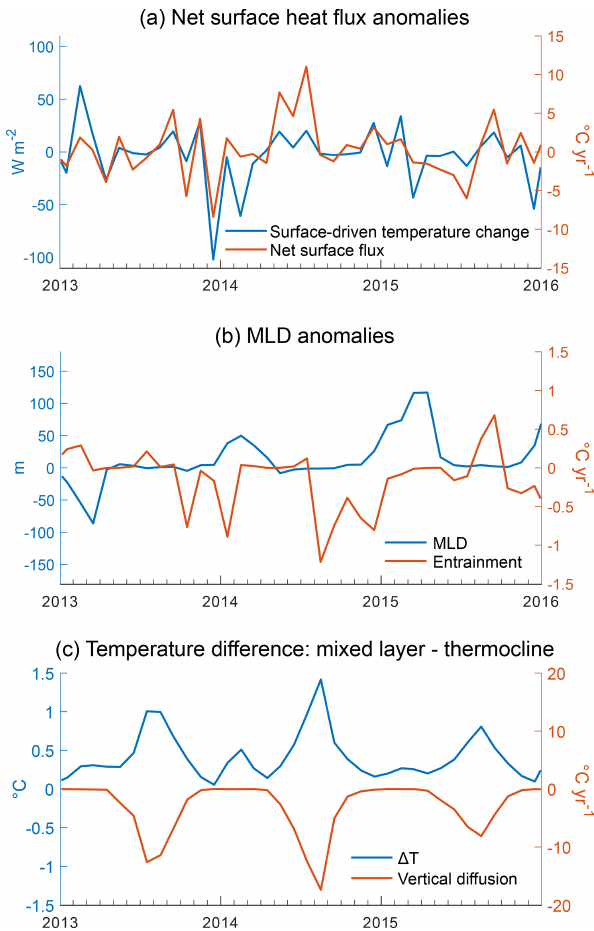
Figure 7. The individual components that comprise the domi- nant temperature budget terms averaged over the cold blob region. (a) Anomalies in the net surface heat flux output by the model, de- fined as Q net in Eq. (1) (Wm − 2 ; blue), and anomalies in the associ- ated change in mixed-layer temperature, i.e. the surface flux term of the budget ( ◦ Cyr − 1 ; red). (b) Anomalies in MLD (m; blue) and the associated entrainment term of the budget ( ◦ Cyr − 1 ; red). (c) The temperature difference between the mixed layer and the model cell immediately beneath ( ◦ C; blue), defined as (cid:49)T in Eq. (1), where positive values signify that the mixed layer is warmer than the ther- mocline and the associated vertical diffusion term of the mixed- layer budget ( ◦ Cyr − 1 ; red). Note that the seasonal cycle has not been removed in (c) . The time series of (a) and (b) prior to the re- moval of the seasonal cycle can be seen in Fig.